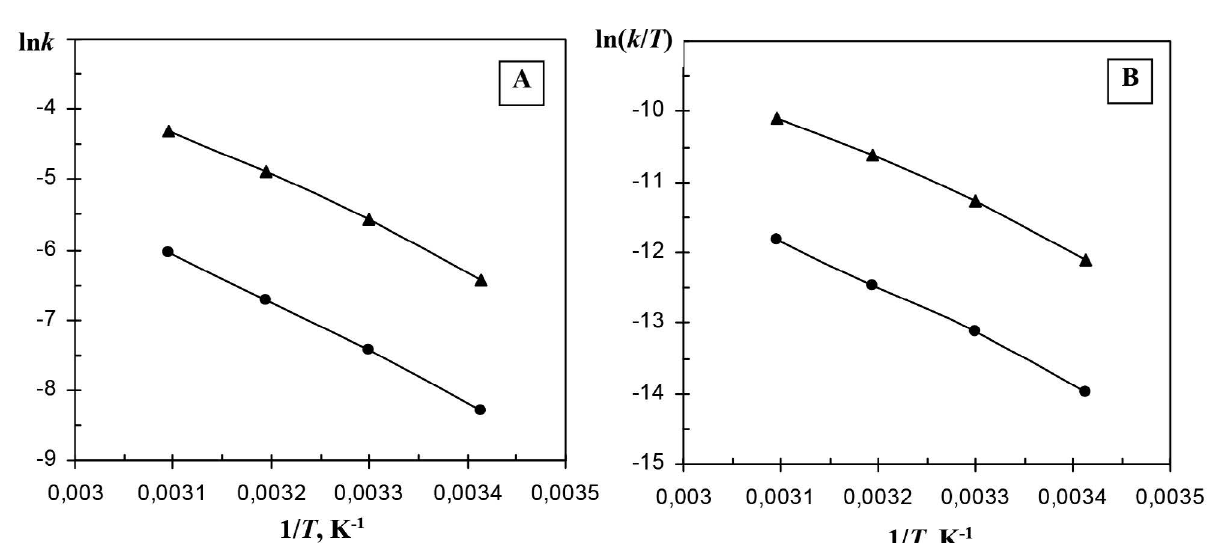
Litvin et al.: Growth of Silver Nanoparticles Using ...